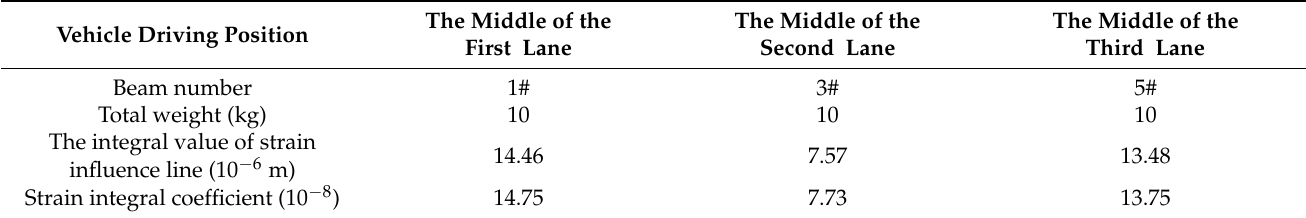
Figure 7. The middle-span strain influence line of ( a ) 1# beam, ( b ) 3# beam, ( c ) 5# beam. Table 1. The strain integral coefficient.